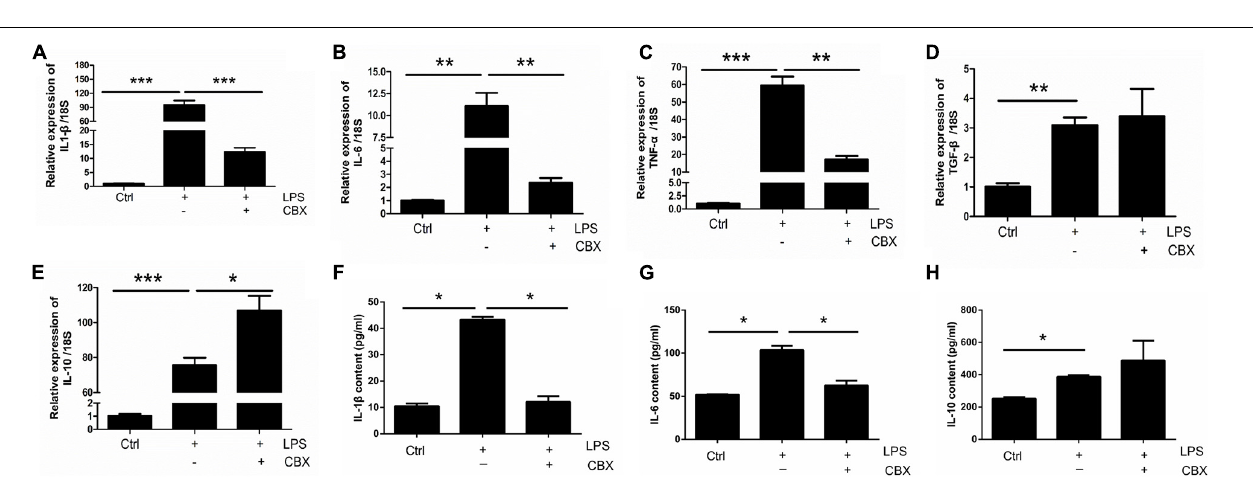
FIGURE 5 | CBX inhibits LPS-induced inflammatory cytokine expression in primary cultured astrocytes. Analysis of the selected inflammatory cytokine mRNA expression by qPCR assay, including IL-1 β (A) , IL-6 (B) , TNF- α (C) , TGF- β (D) , and IL-10 (E) in primary cultured astrocytes. Cells were pretreated with Panx 1